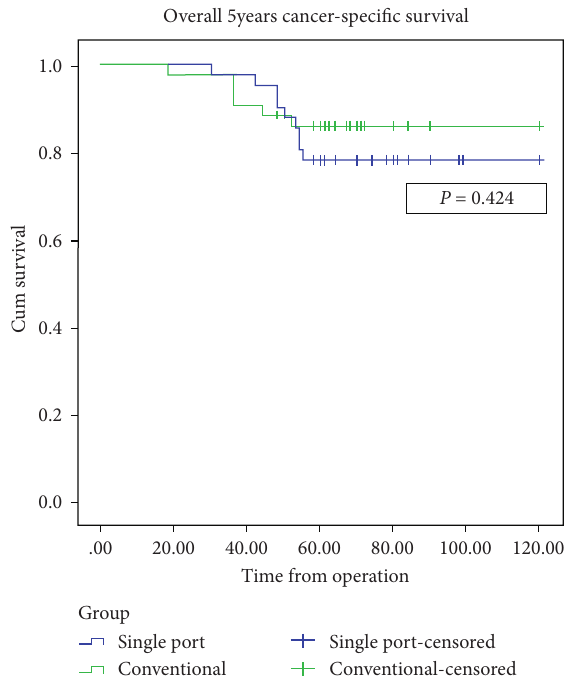
Figure 1: Kaplan–Meier curve of overall cancer